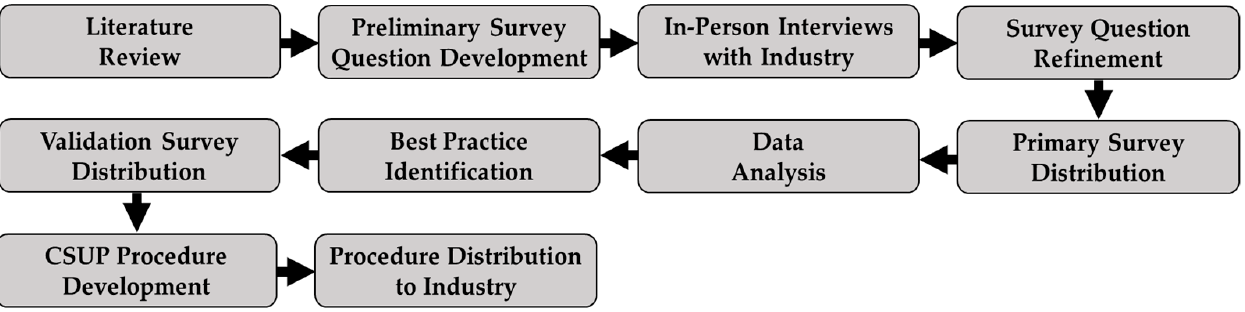
Figure 1. Research organizational flowchart.